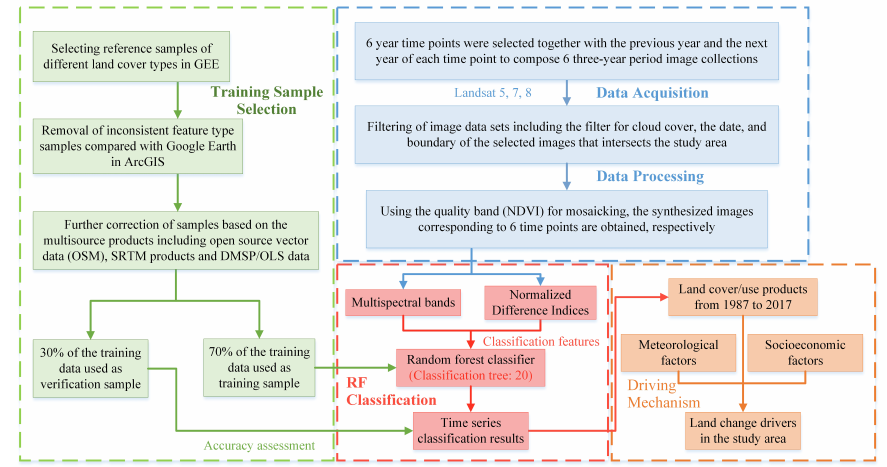
Figure 3. Flowchart of land-cover mapping and the mechanism analysis. Land-cover mapping included the data acquisition and processing, training-sample selection, and random forest (RF)